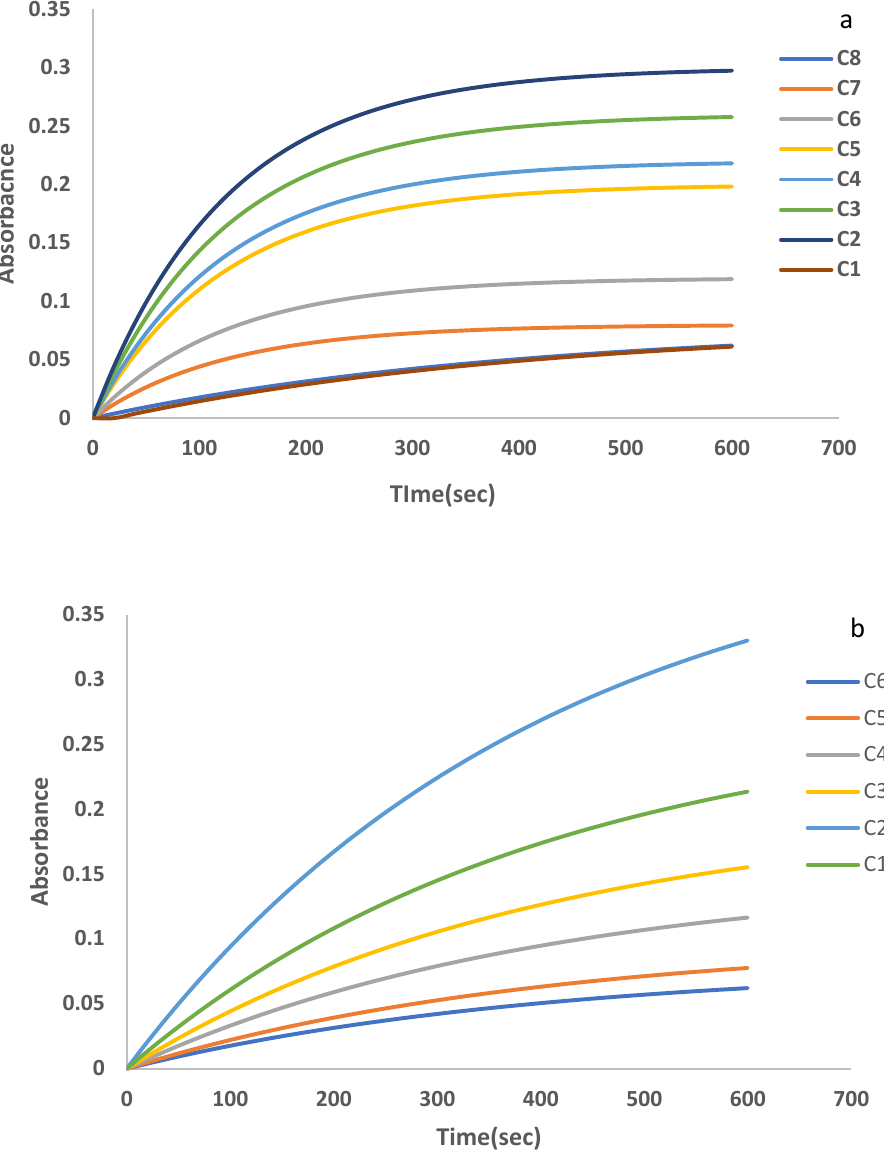
Figure 3. ( a ) Kinetic profiles of randomly selected mixtures of ( a ) UA 5, 10, 20, 30, 40, 50 and 55 µ mol L − 1 and ( b ) DA 7, 10, 15,20, 30, and 400 µ mol L − 1 . Figure 4a represents the graphs of CWT-sym8 signals of analyte solutions at a dilation value of 25. As mentioned before, CWT-sym8 calibration equations were extracted at the zero-crossing points based on their maximum sensitivity and selectivity (minimum overlapping). Therefore, times of 220 s for the determination of UA at zero-crossing points of DA and 140 s for determination of DA at zero-crossing points of UA were selected. Linear regression analysis and the statistical parameters of calibration sets are shown in Table